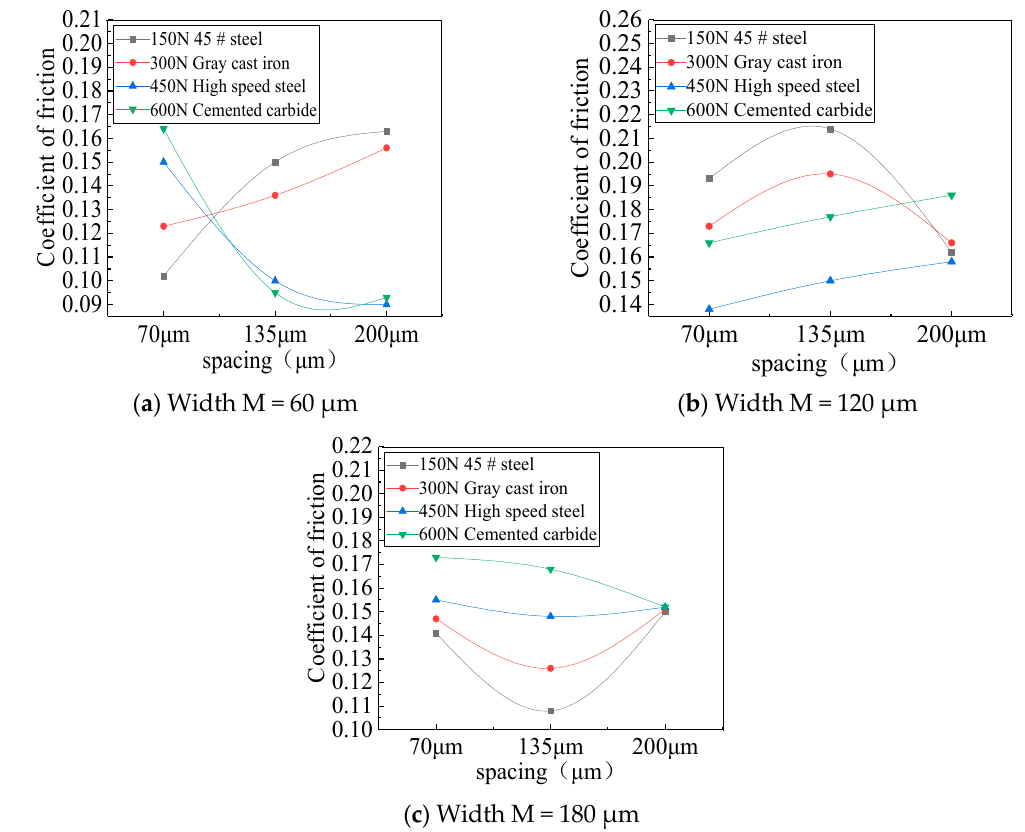
Figure 9. Effect of spacing on the coefficient of friction under different widths. Figure 9. E ff ect of spacing on the coe ffi cient of friction under di ff erent